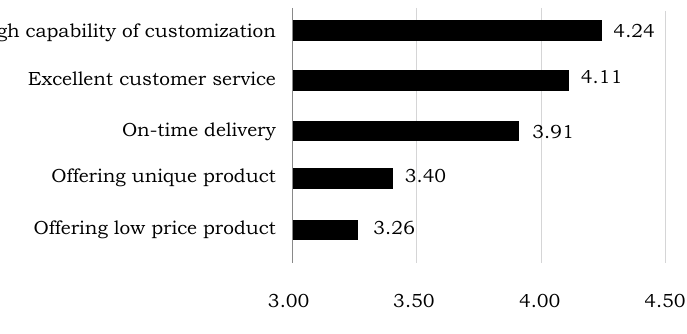
Figure 2. Market-level